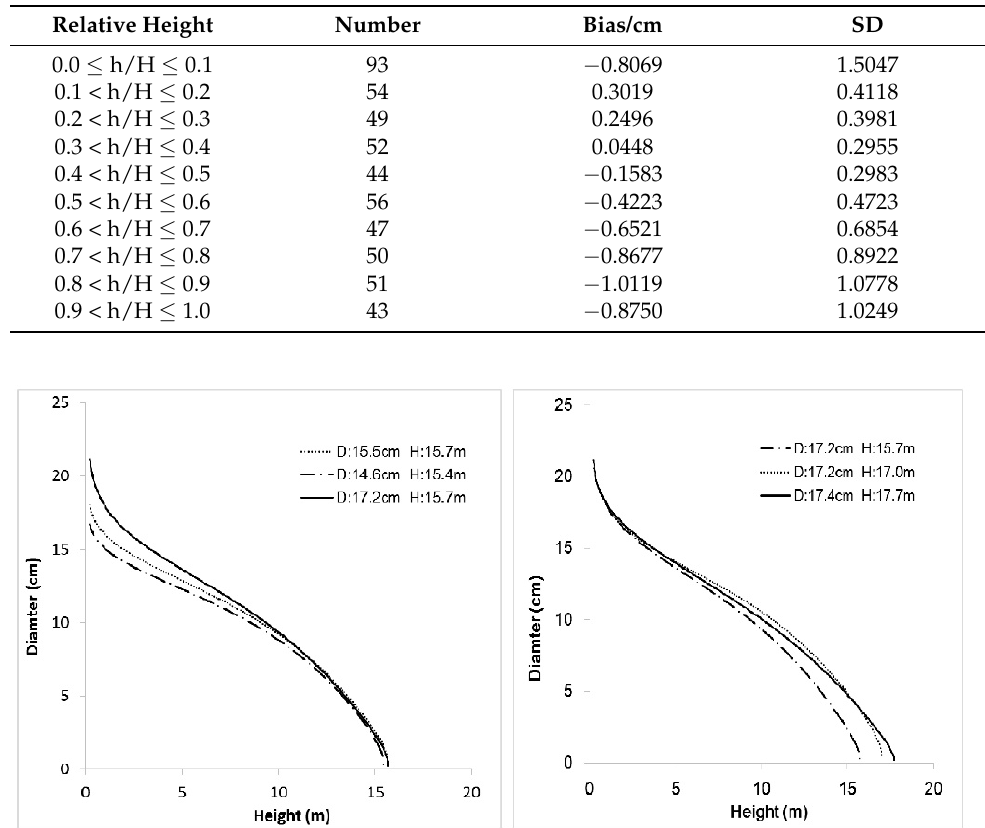
Figure 3. Taper profiles for three different diameter at breast height (DBH) and the similar height tree, three different height and the similar DBH tree in Kozak [1] with tree-level effects NLME model.